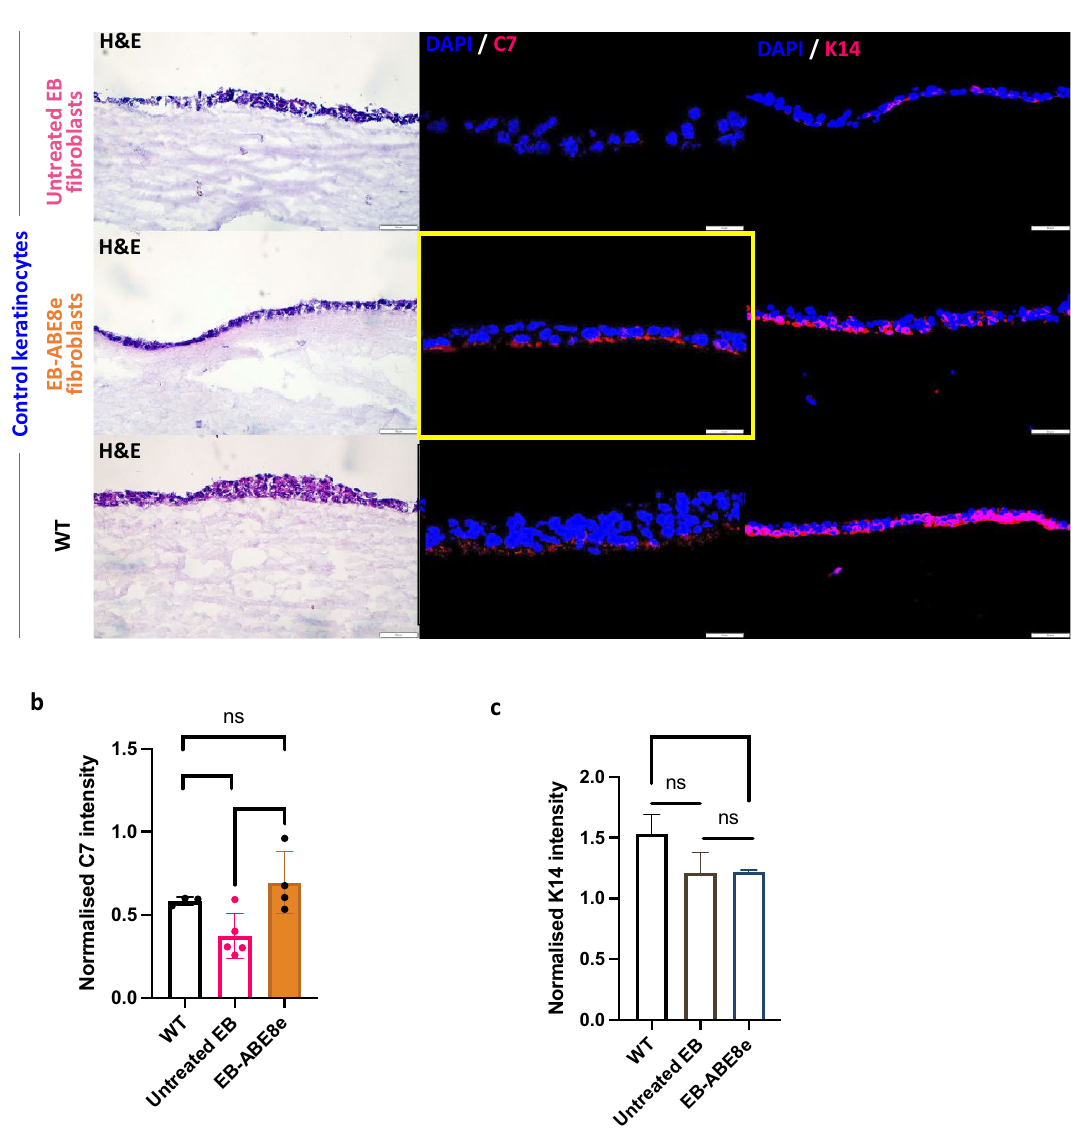
Figure 5. Histology and expression of collagen type VII (C7) and keratin 14 (K14) in skin constructs containing either untreated EB, ABE8e treated or Wild Type fibroblasts (WT) in combination with control keratinocytes. ( a ) Staining for C7 using LH7.2 monoclonal antibody reveals that gene editing of EB fibroblasts with the high dose of ABE8e base editor restored C7 expression at the dermal–epidermal junction in skin equivalent cultures created with healthy control keratinocytes. Images of skin constructs cryosections have been taken under bright light (H&E staining) or fluorescent microscope (C7 and K14 expression in immunofluorescent staining with DAPI showing nuclei); scale bars measuring 50 µm. ( b ) Quantification of C7 intensity normalised by cell number found a significant increase in C7 intensity between untreated EB and EB-ABE8e and no significant difference in C7 intensity between WT and treated cells. t -test performed. ( c ) Quantification of K14 intensity normalised by cell number found no significant difference between WT and untreated EB or untreated EB and EB-ABE8e however there was a significance difference between WT and EB-ABE8e K14 intensity. t -test penicillin/streptomycin, (Invitrogen). The fibroblasts were grown at 37 °C and 5% CO 2 and routinely passaged using TrypLE™ Express (Gibco) as a gentle trypsin replacement enzyme to detach and dissociate the cells. sgRNA design. The sgRNA targeting the c.5047 C > T mutation of the COL7A1 gene were designed using the CRISPR RGEN guide-RNA designer tool for base editing 19 (http:// www. rgeno me. net/ be- desig ner/). The guides were manufactured as synthetic sgRNA chemically modified molecules by Synthego and Invitrogen.